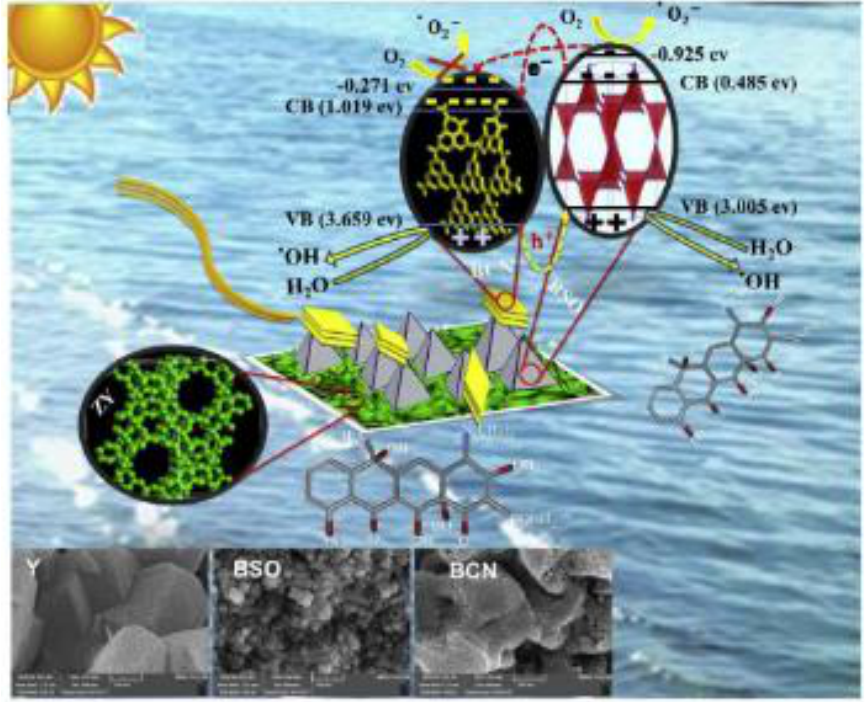
Figure 17. Reaction mechanism for the removal of tetracycline from water over the Bi 2 Sn 2 O 7 -C 3 N 4 /Y nano-photocatalyst. Reprinted with permission from [50].